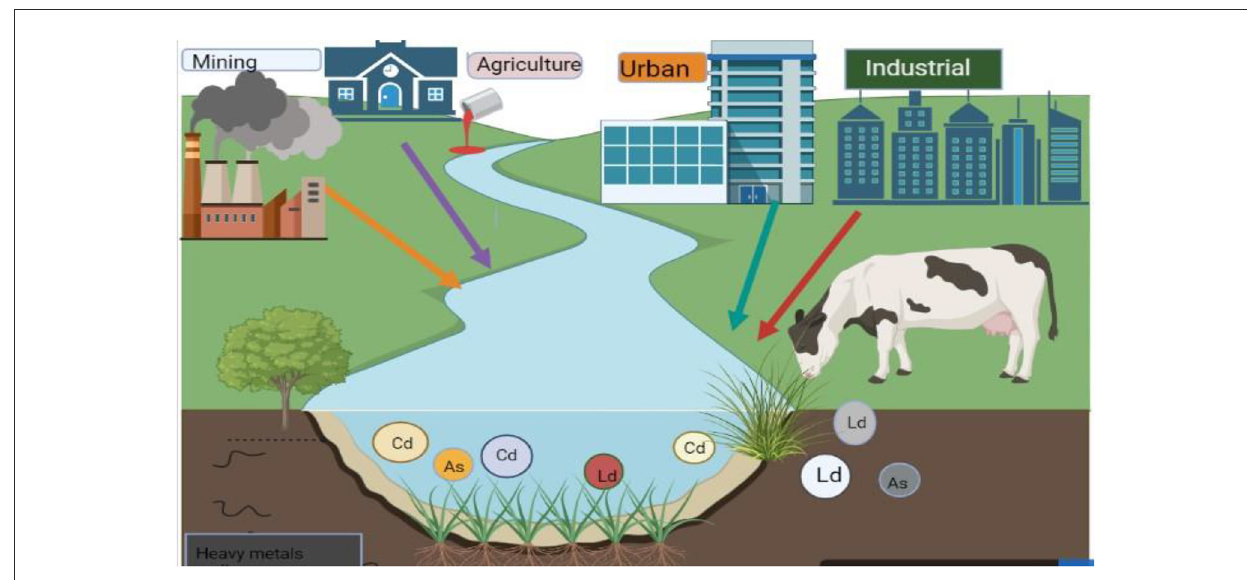
FIGURE1 Source of heavy metals toxicity in animals (derived from bio